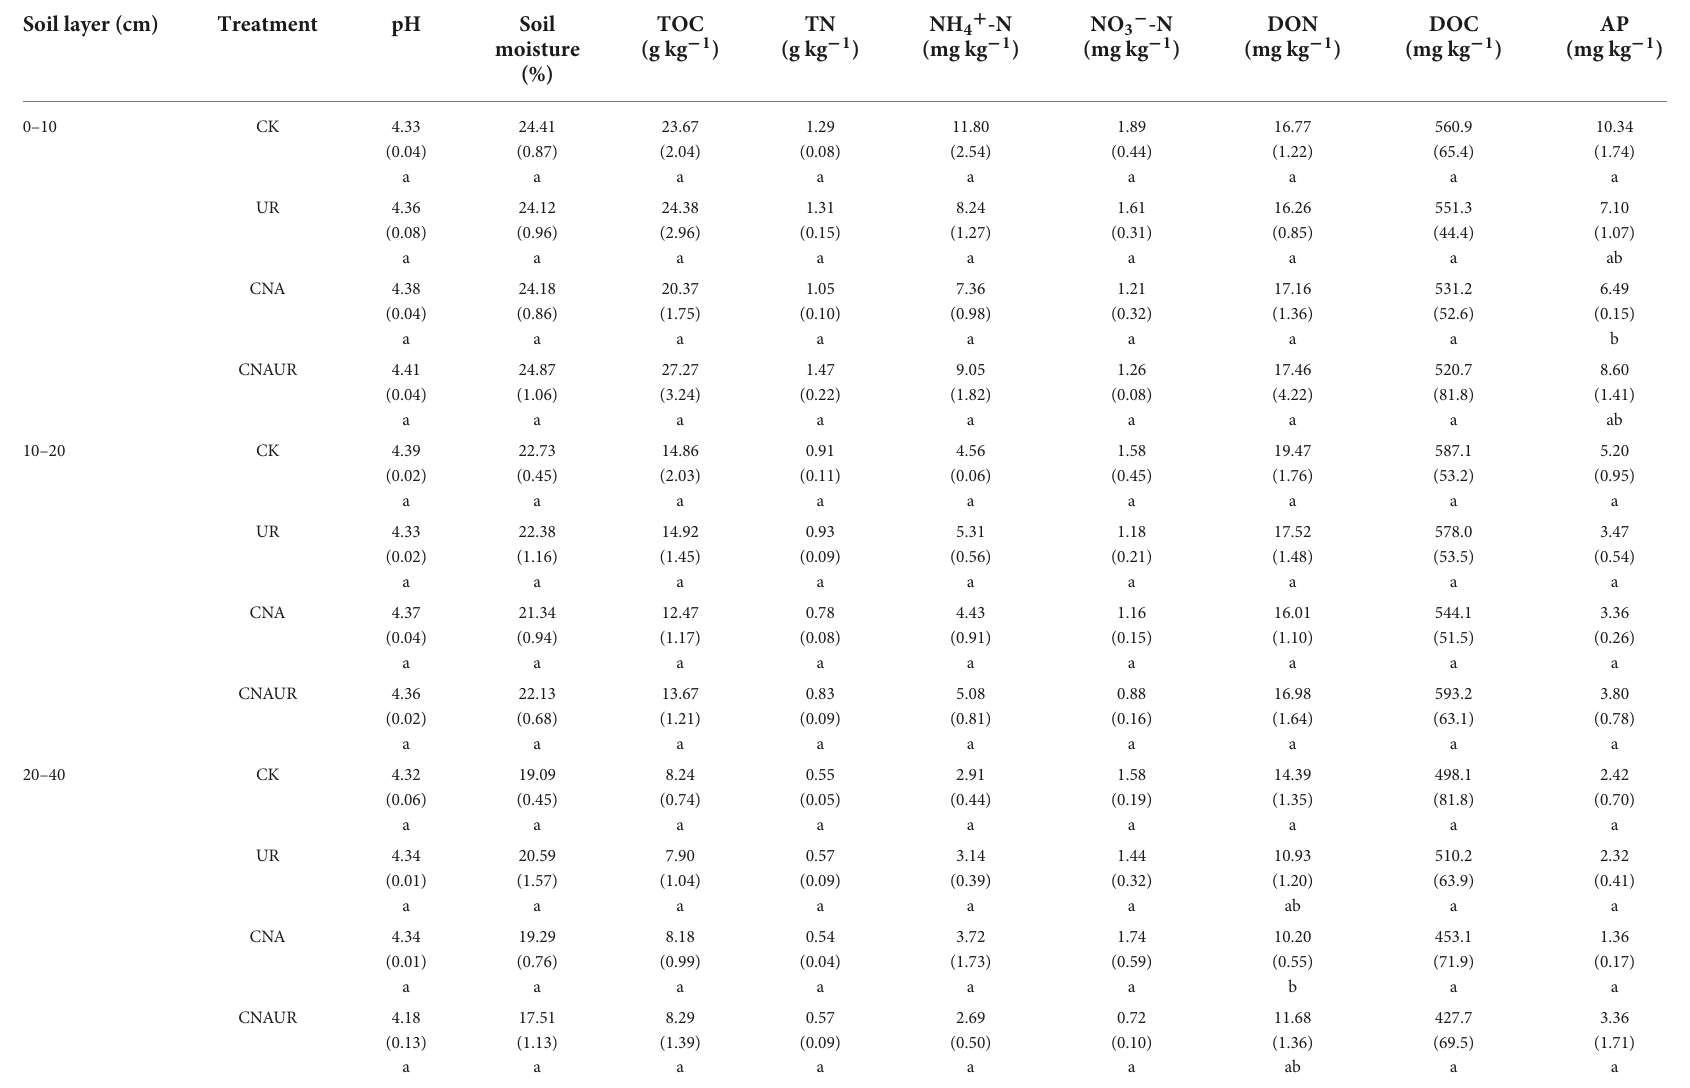
TABLE 1 Soil properties under different